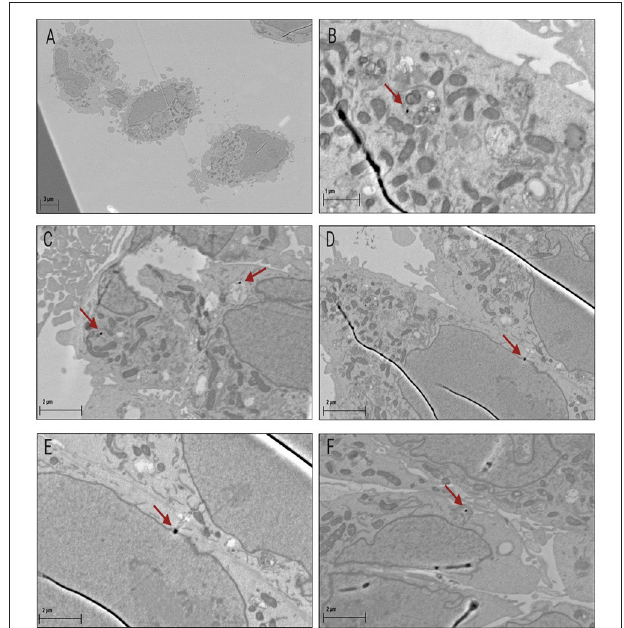
FIGURE 3 | Confirmed uptake of AuNPs in CHO-K1 cells with TEM. Image (A) represents three untreated control cells captured at a higher magnification than panels (B-F) , which represent cells that were exposed to 50nm AuNPs. Images (B–F) show that low numbers of AuNPs were taken up by the cells, but were successfully internalized. AuNPs localized randomly into vacuoles within the cells (B, C and D) . AuNPs were also located within proximity to the nuclear membrane (F) as well as integrated into the nuclear membrane of the cells (D and E)